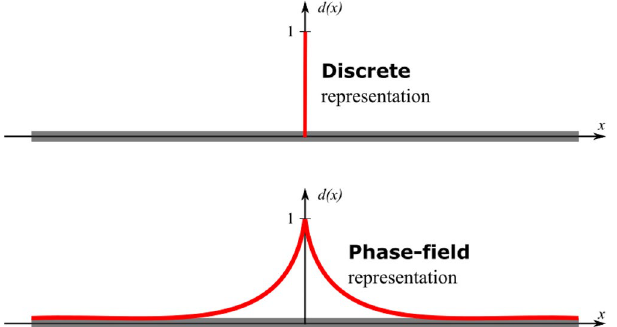
Figure 1. Sketch of a discrete fracture (top) and the phase-field representation (bottom). The phase-field representation captures the fracture by a continuous